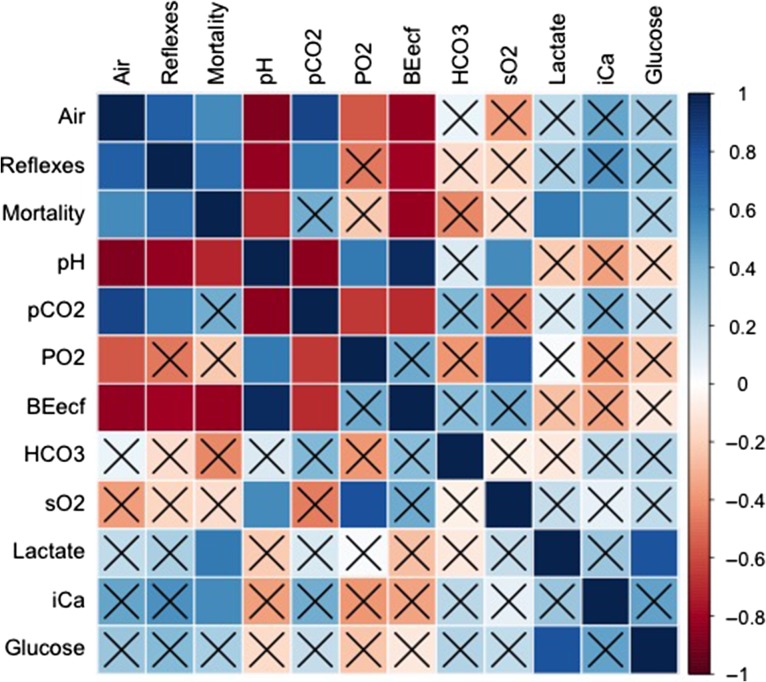
Results of Pearson correlation between air exposure, reflex impairment, physiological parameters and delayed mortality. Variables that are not significant (P > 0.05) are crossed out.